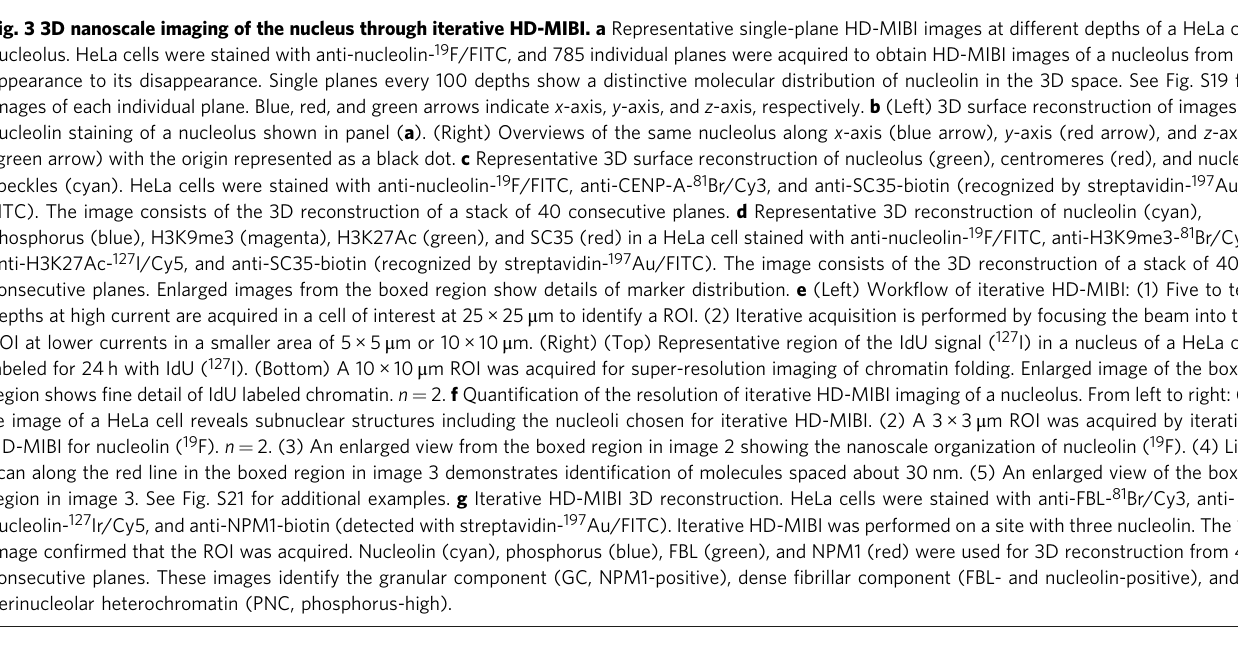
on these groups for visualization purposes (Fig. 4b, bottom left).